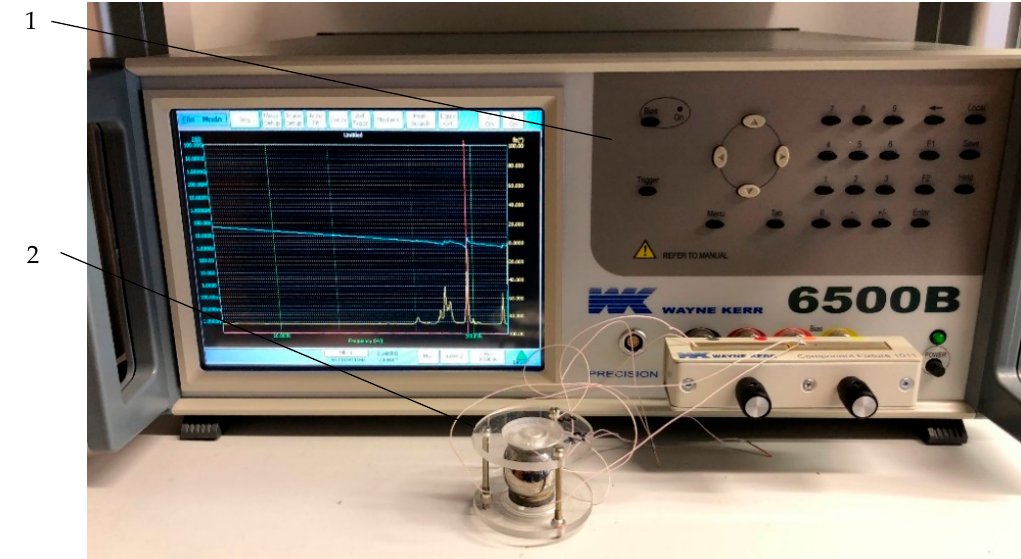
Figure 12. The setup for impedance analysis. 1—Kayne Kerr 6500B impedance analyzer; 2—USM with spherical rotor.